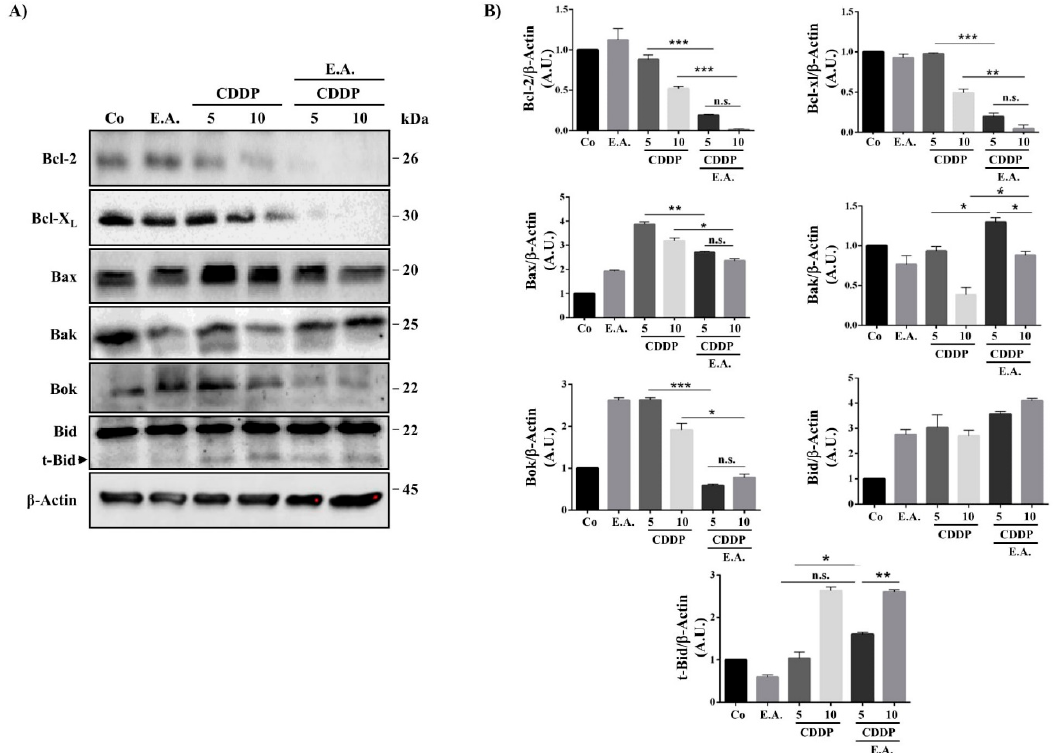
Figure 5. E.A./CDDP combination synergized to strongly affect Bcl ‐ 2 family protein expression in Figure 5. E.A. / CDDP combination synergized to strongly a ff ect Bcl-2 family protein expression breast cancer cells. ( A ) Immunoblotting analysis of indicated proteins in 4T1 cells exposed for 48 h to the vehicle (Co) or to E.A. (6 μ g/mL), CDPP (5 and 10 μ M), or to the combination of E.A (6 μ g/mL)